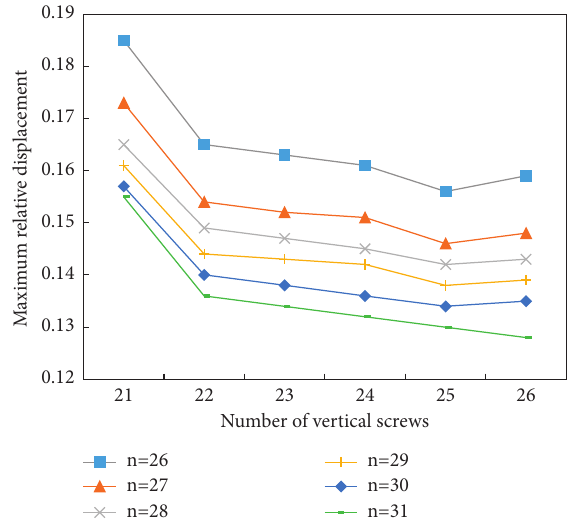
Figure 10: Diagram of the number of screws in the horizontal direction under dangerous load